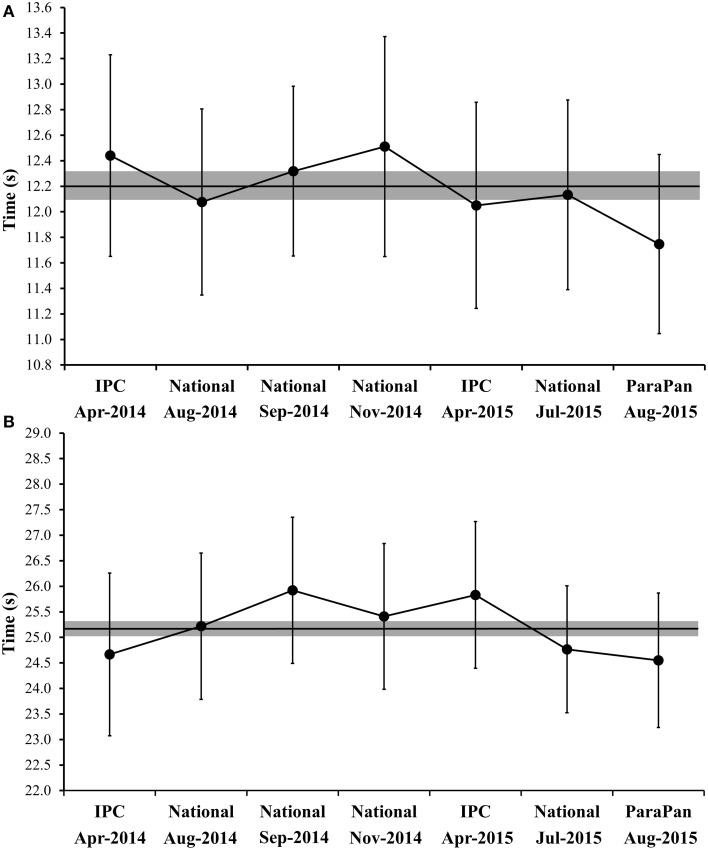
Variation in 100- (A) and 200-m (B) dash performances across seven official competitions. The black line represent the mean individual performances, and the gray area represent the smallest important effect on performances (i.e., calculated as half of the within-athlete race-to-race variability). National corresponds to competitions organized by the local Paralympic Committee; IPC corresponds to international competitions organized by the International Paralympic Committee; ParaPan corresponds to the ParaPan American Games.